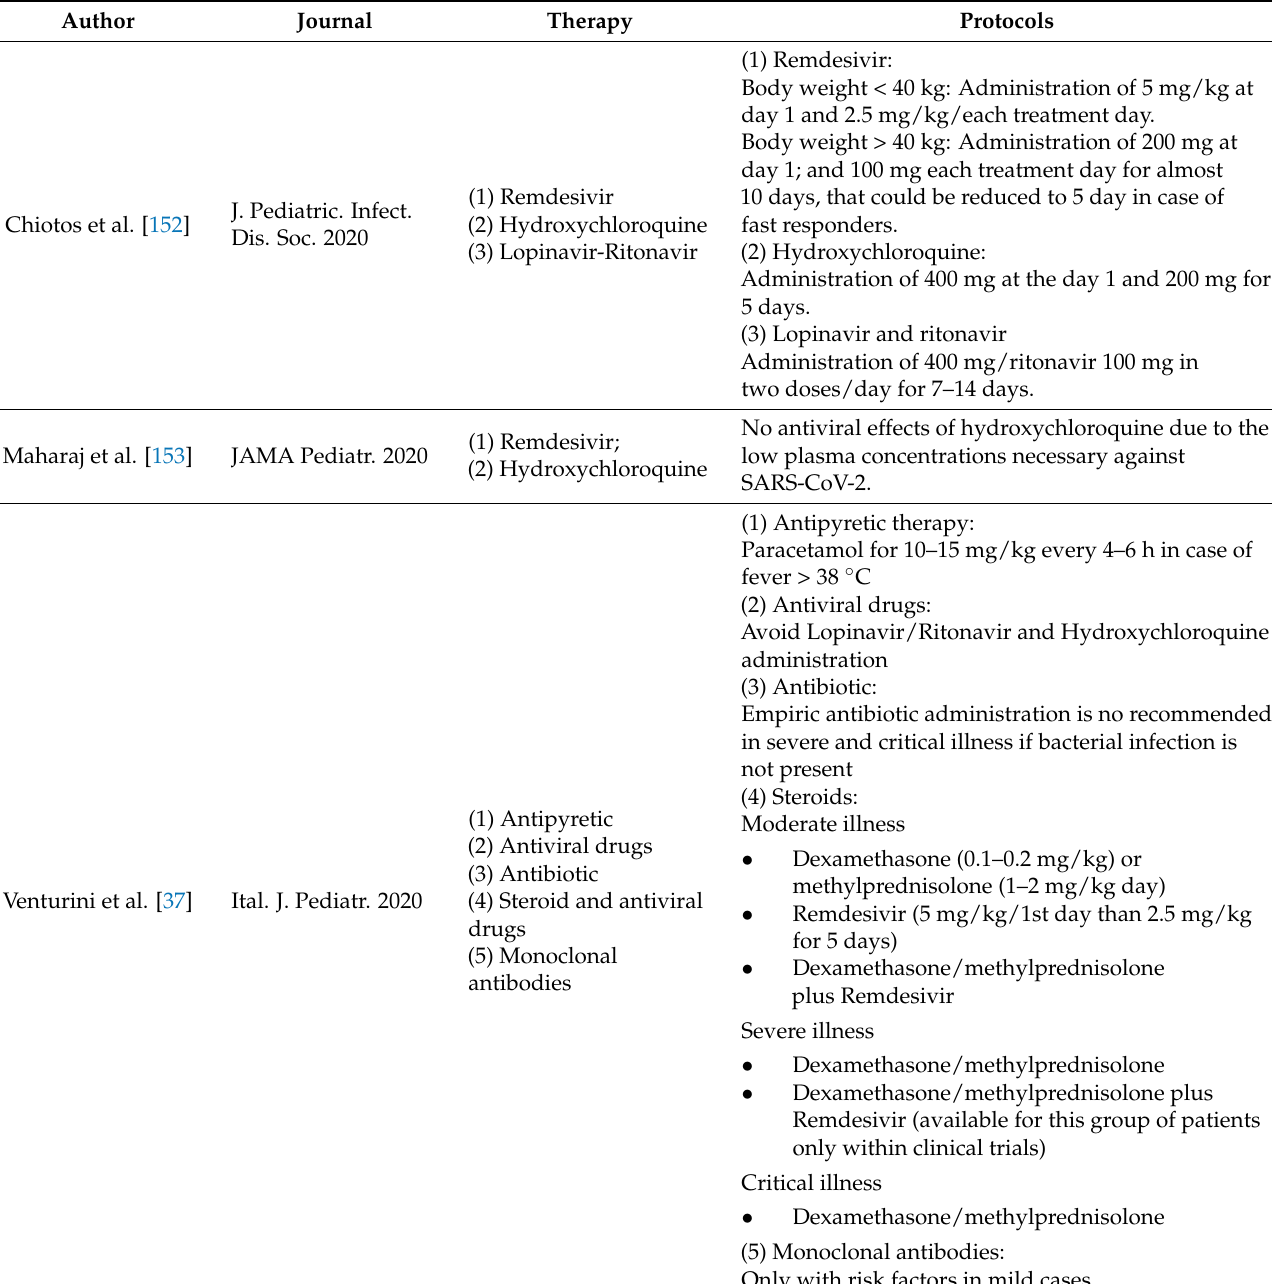
Table 2. COVID-19